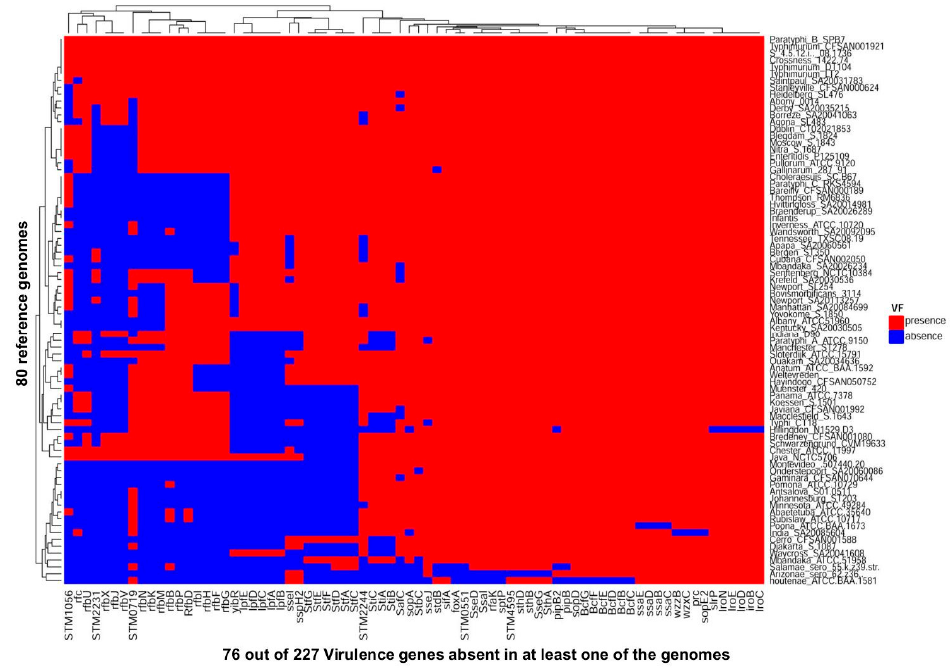
Figure 2. Distribution of 227 virulence genes in 80 reference Salmonella genomes used in designing the AmpliSeq Salm_227VG panel. Red and blue colors represent gene presence and absence, respectively. The x axis contains the list of 76 80refs variable genes which are absent in at least one genome and the y axis shows the 80 Salmonella enterica reference genomes.